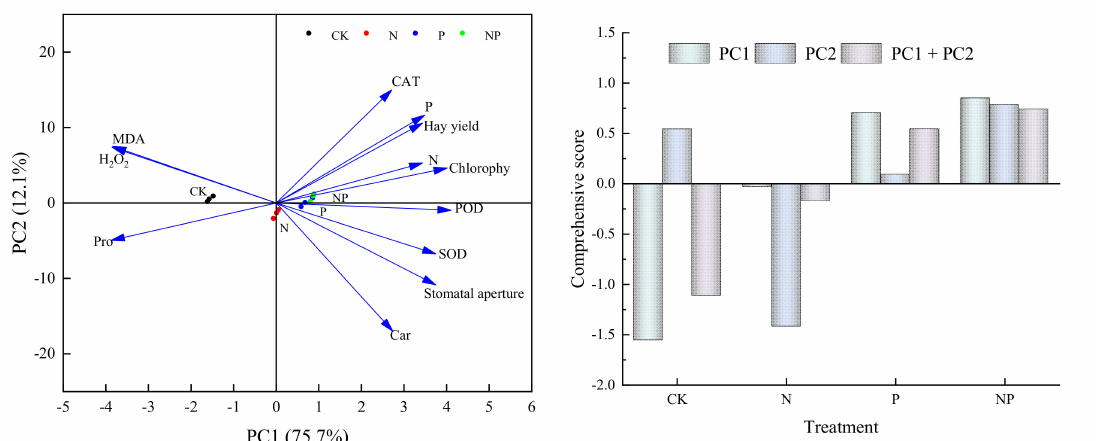
Figure 7. Relationship between leaf physiological factors and alfalfa hay yield under nitrogen and phosphorus treatments and its comprehensive